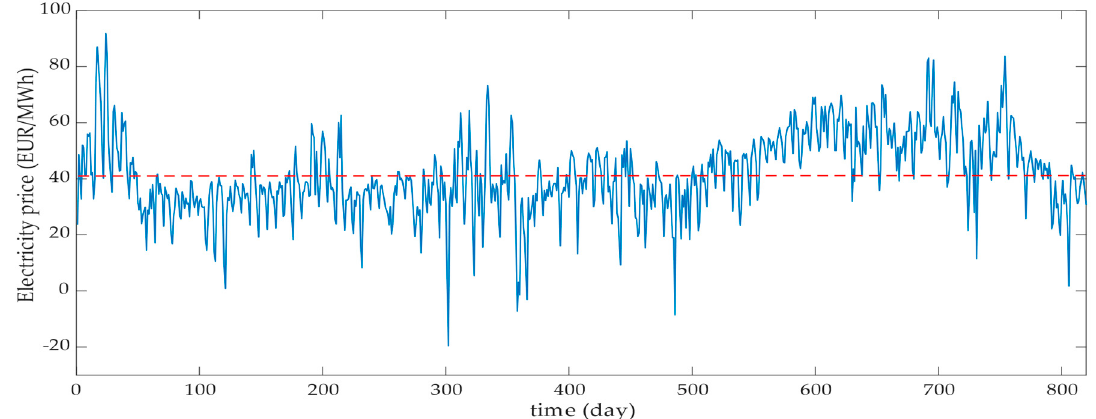
Figure 20. Historical day weighted electricity prices on the spot intraday power market.